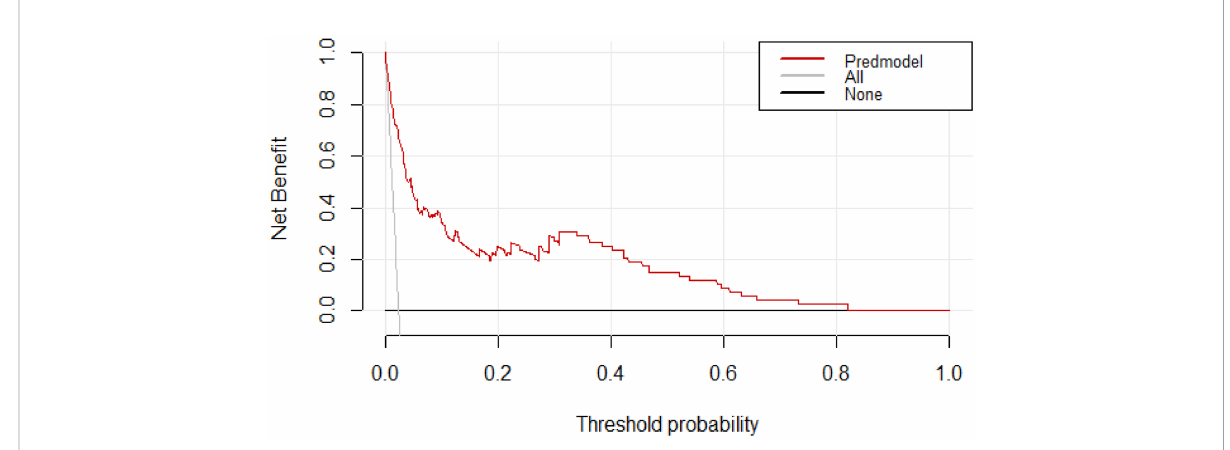
FIGURE 5 Decision curve analysis (DCA) for assessment of the clinical utility for thromboprophylaxis. The threshold probability represents the predicted risk of VTE for recommending primary thromboprophylaxis.The net bene fi t balances the risk of VTE with the potential harms of unnecessary thromboprophylaxis and is equal to the true-positive rate minus the weighted false-positive rate.